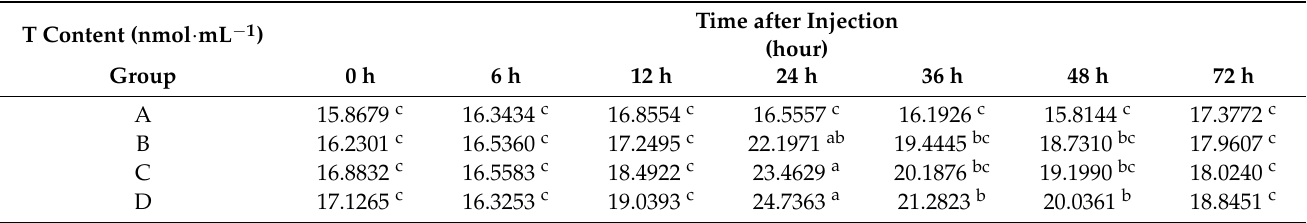
Table 3. Change of serum T content in Nile tilapia serum after oxytocin